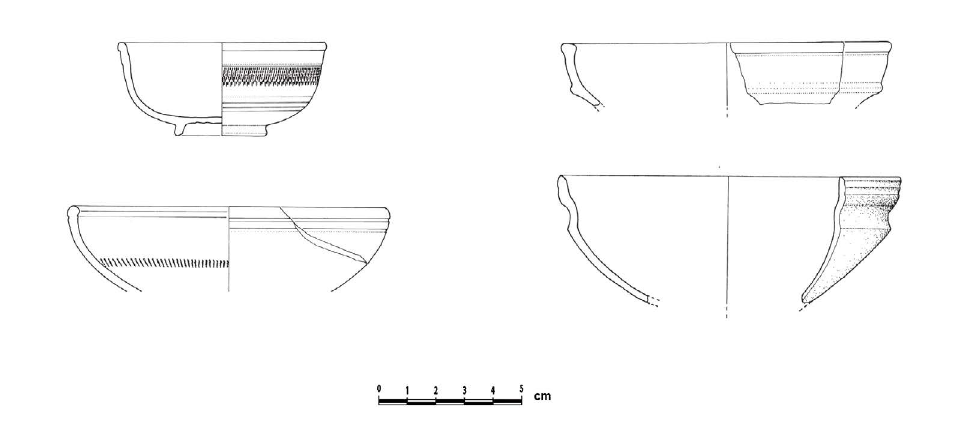
Figure 4: Examples of Pannonian slipped ware.